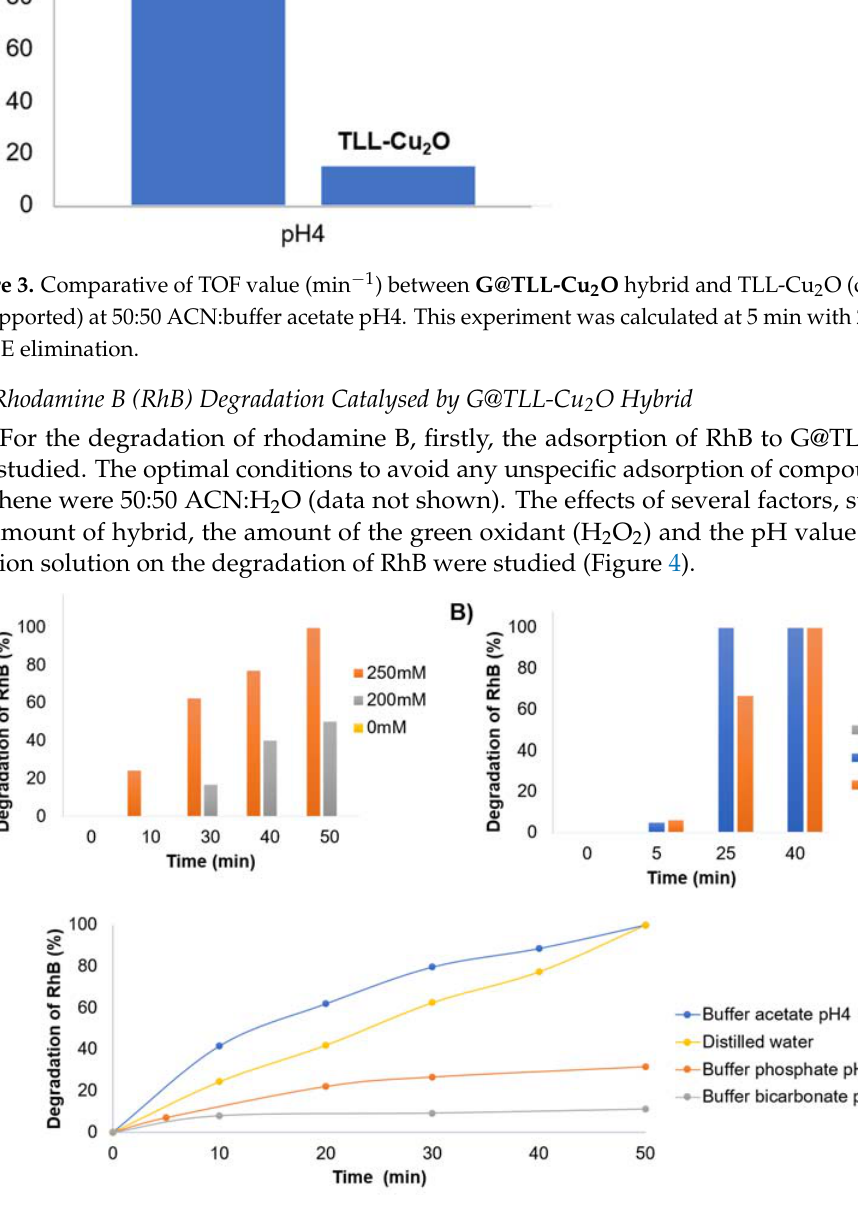
Figure 4. Degradation of 0.1 mM (48 ppm) of RhB at r.t. and natural light. ( A ) Effect of the amount of H 2 O 2 with 5 mg of G@TLL ‐ Cu 2 O hybrid; ( B ) Effect of the amount of G@TLL ‐ Cu 2 O hybrid with 250 mM of H 2 O 2 ; ( C ) Effect of medium pH, conditions: 50:50 ACN:Buffer with 5 mg of G@TLL ‐ Cu 2 O hybrid and 250 mM of H 2 O 2 .